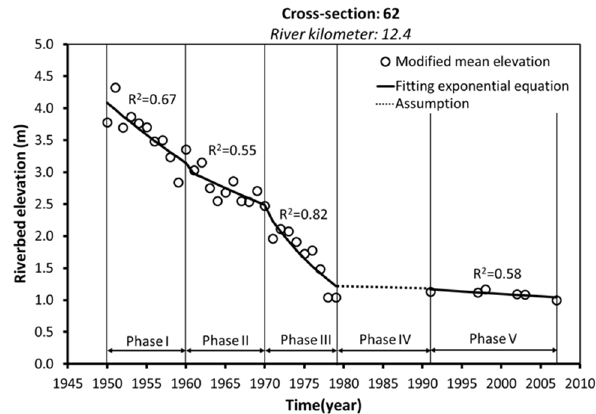
Figure 2. Fitting exponential equations to temporal vertical adjustment at the 62nd cross-section.